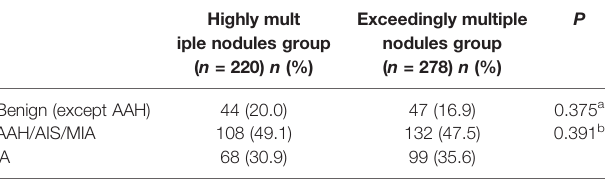
TABLE 4 | Pathological analysis of ground-glass nodules.